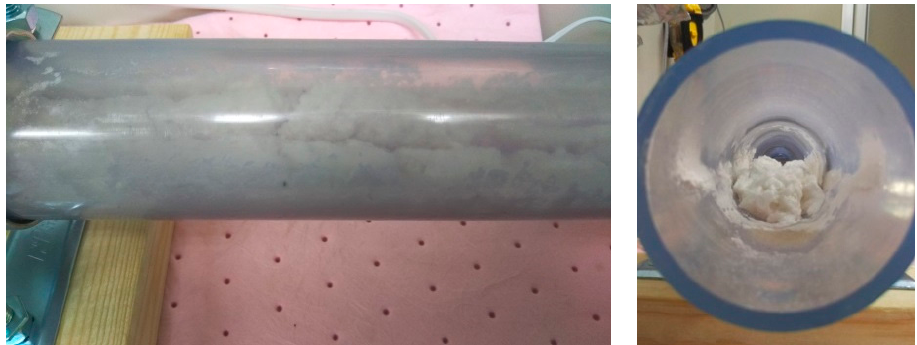
Figure 4. Clogging inside the sewer pipe on the 7th day in the simulated experiment (Observation point 4).